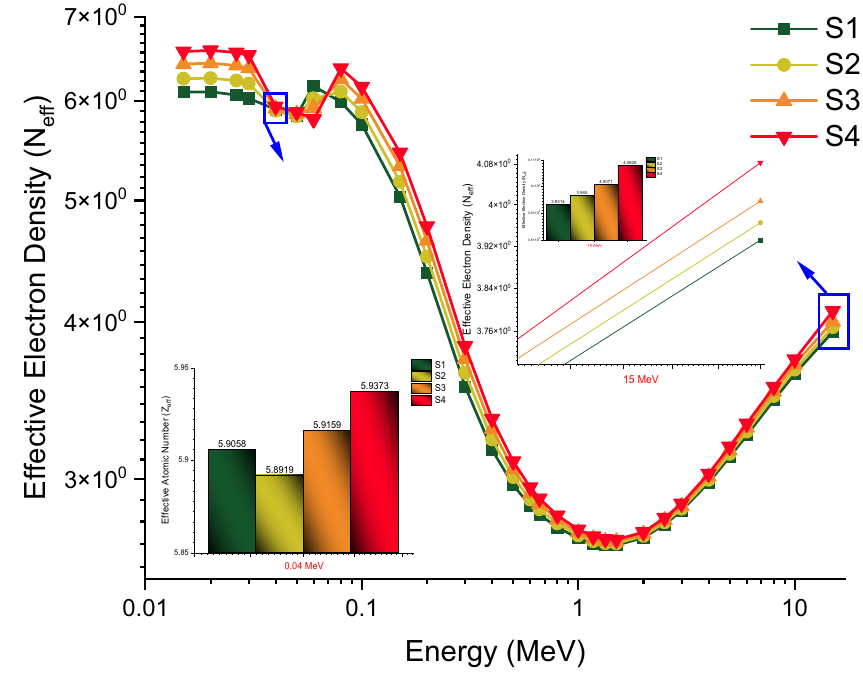
Figure 8: Variation in e ff ective electron density ( electrons/g ) with photon energy ( MeV ) for all S1 – S4